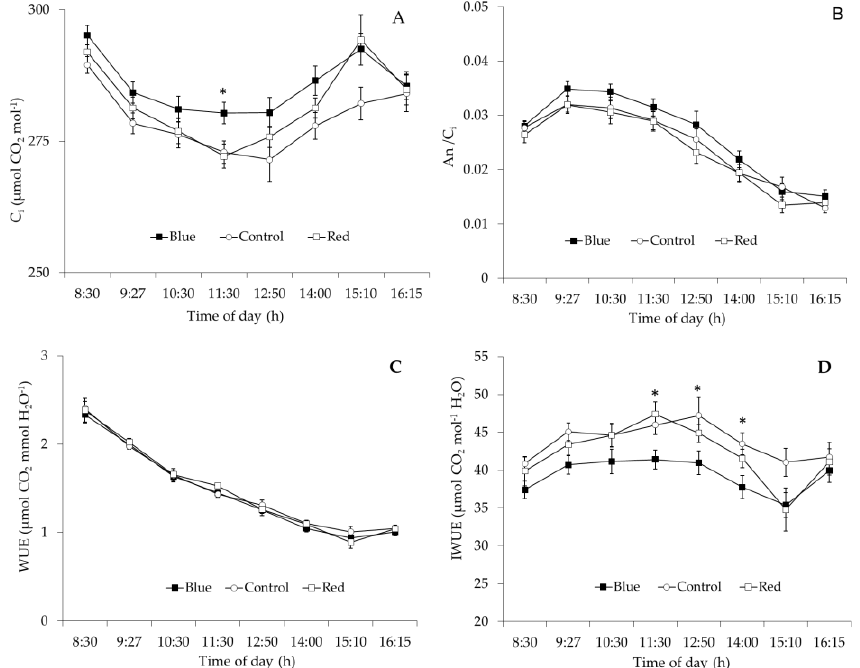
Figure 6. ( A ) Daily course of intercellular CO 2 concentration, C i ; ( B ); instantaneous carboxylation efficiency, A n /C i ; ( C ) water use efficiency, WUE; and intrinsic water use efficiency, IWUE ( D ) in ‘Fuji’ apple leaves grown under red (□), blue ( ■ ) and white control ( ○ ) nets. Each value represents the mean ± SE of 12 leaves measured under ambient light conditions on two summer days. *: Significant at p < 0.05.